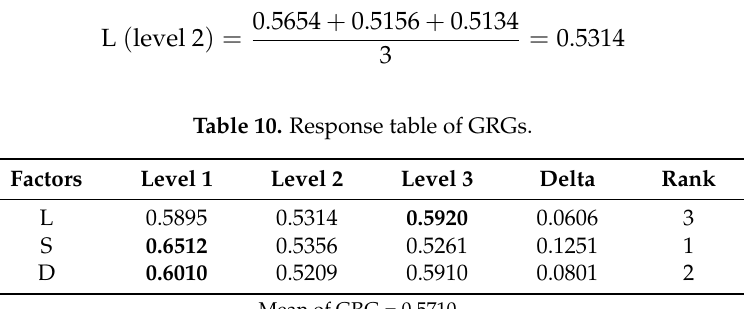
Table 11. ANOVA for grey relational grade.